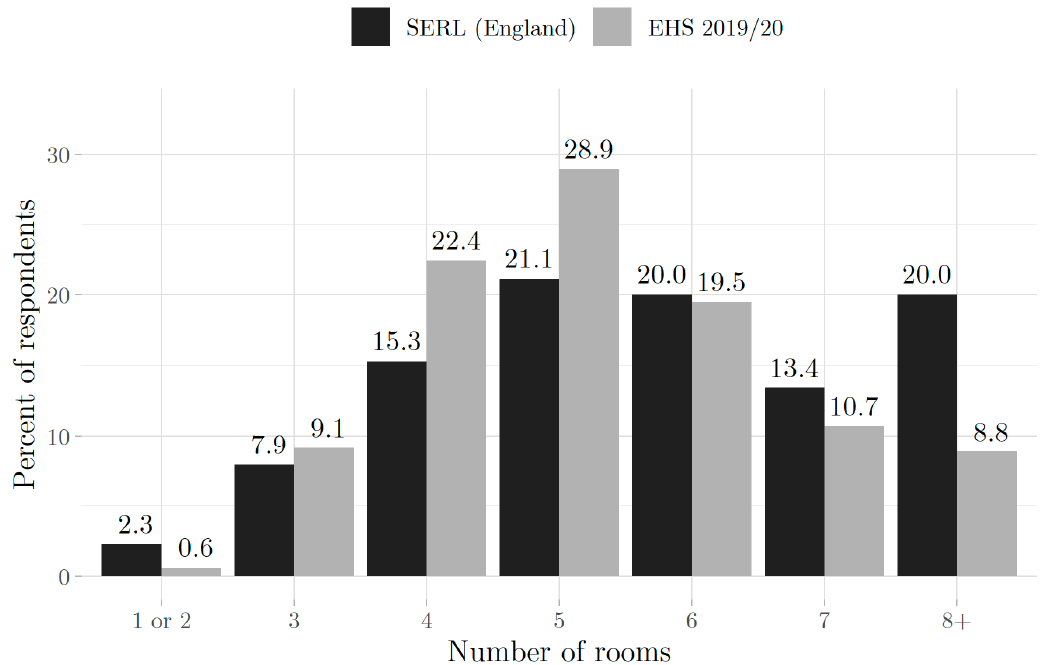
Figure 15. The number of rooms in SERL Observatory dwellings in England (counts rounded down to the nearest 20 for statistical disclosure control) compared to those reported in the EHS 2019/20 survey.